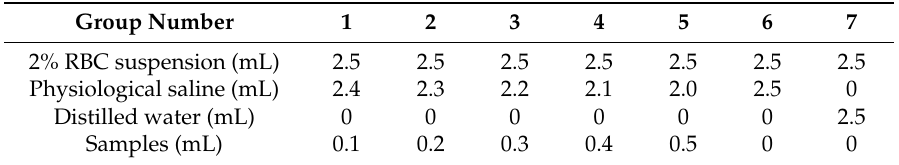
Table 1. Groups of hemolysis test of